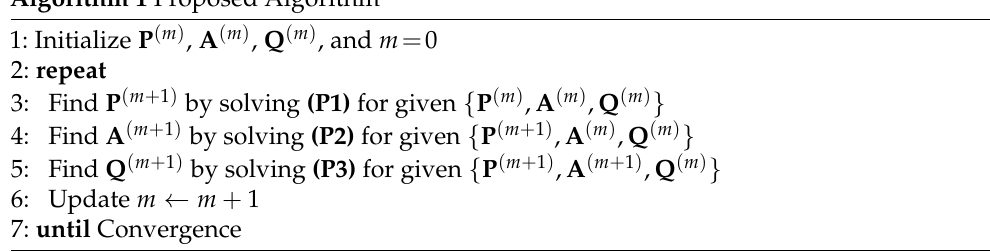
Algorithm 1 Proposed